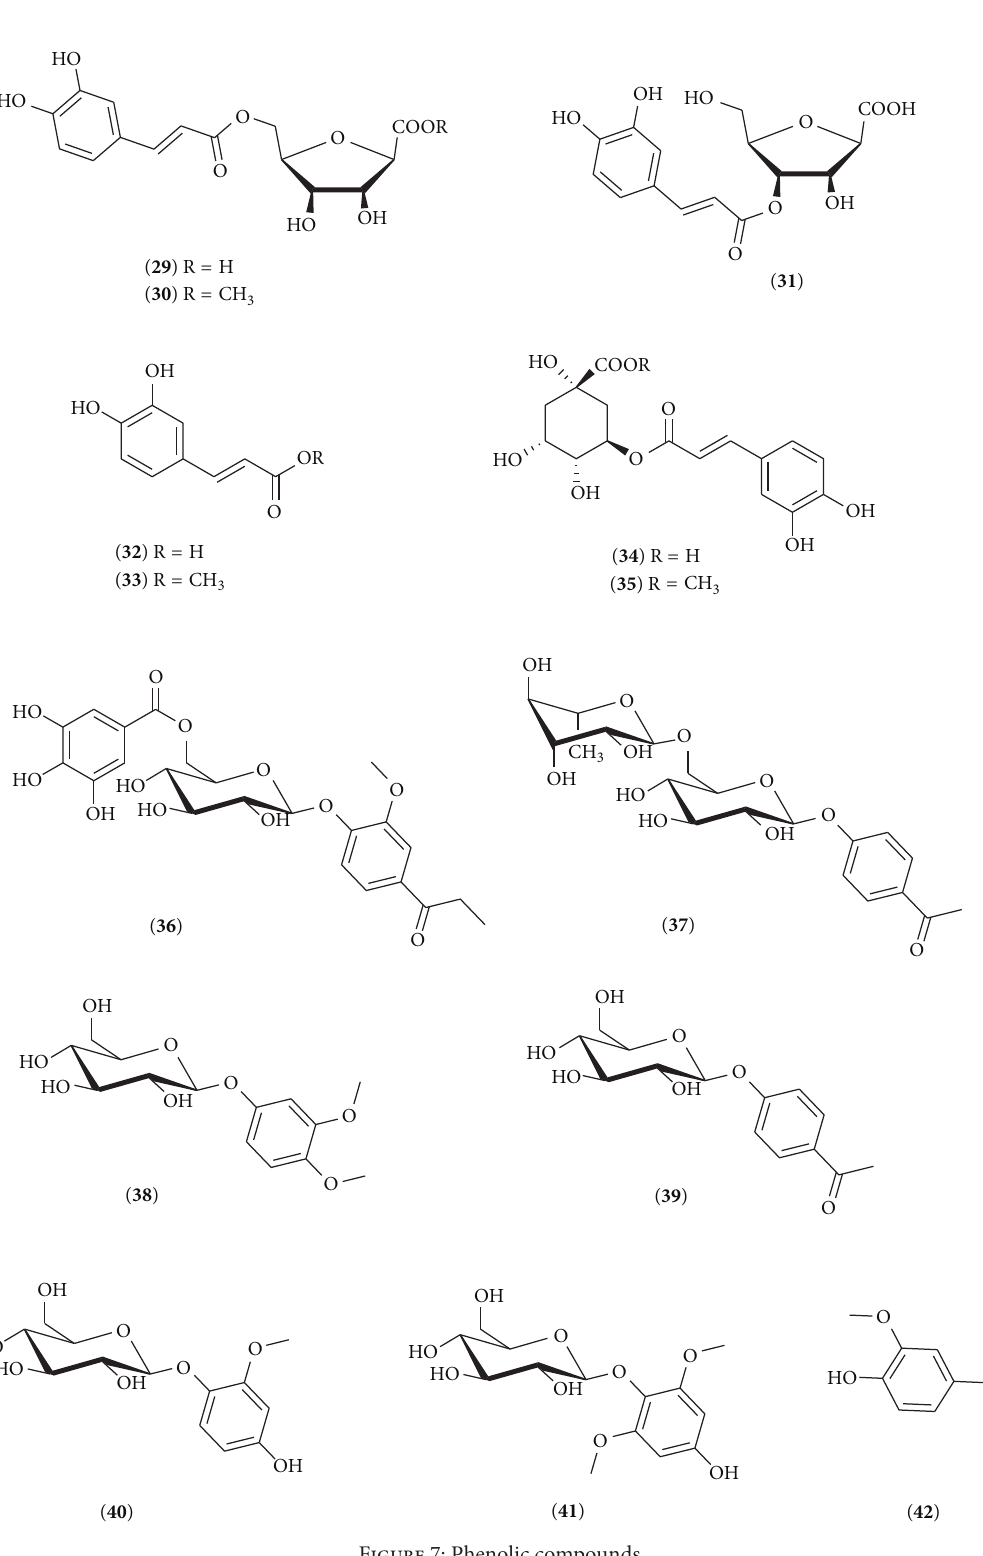
Figure 7: Phenolic